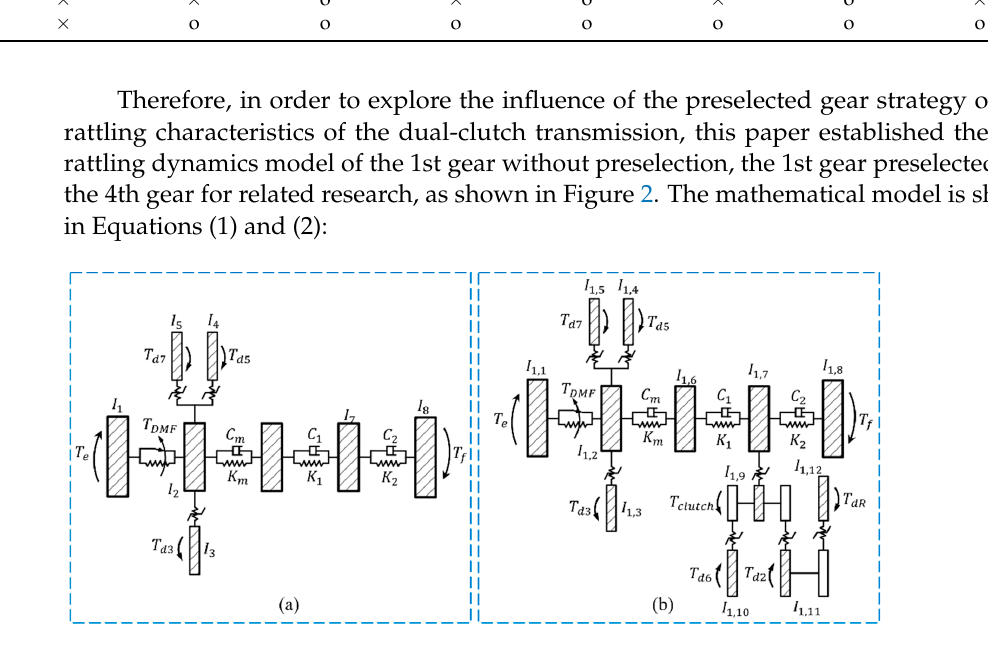
Figure 2. Schematic diagram of dynamic model of multi-gear rattling: ( a ) 1st gear; ( b ) 1st gear pre-selection 4th